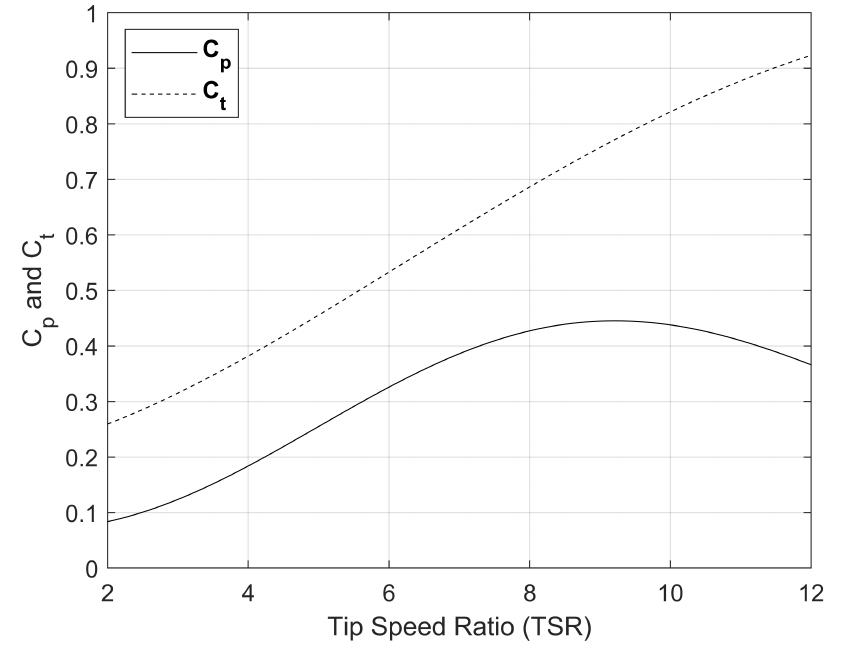
Figure 4. The C p and C t curves of SWT-2.3-93 turbine